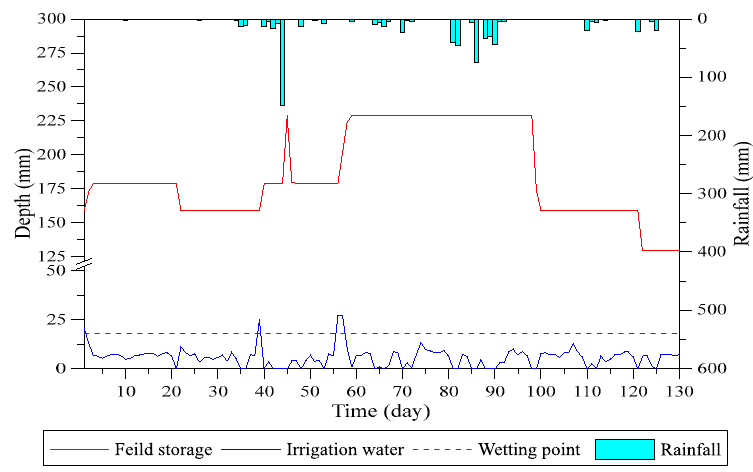
Figure 24. Simulation of block 4 under 50% reduction of planned irrigation water during first crop season.